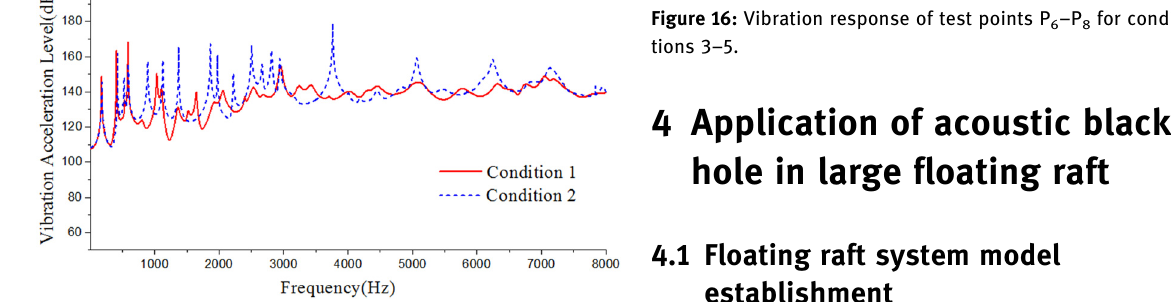
Figure 13: Vibration response of test points P 1 – P 5 for conditions 1 and 2.